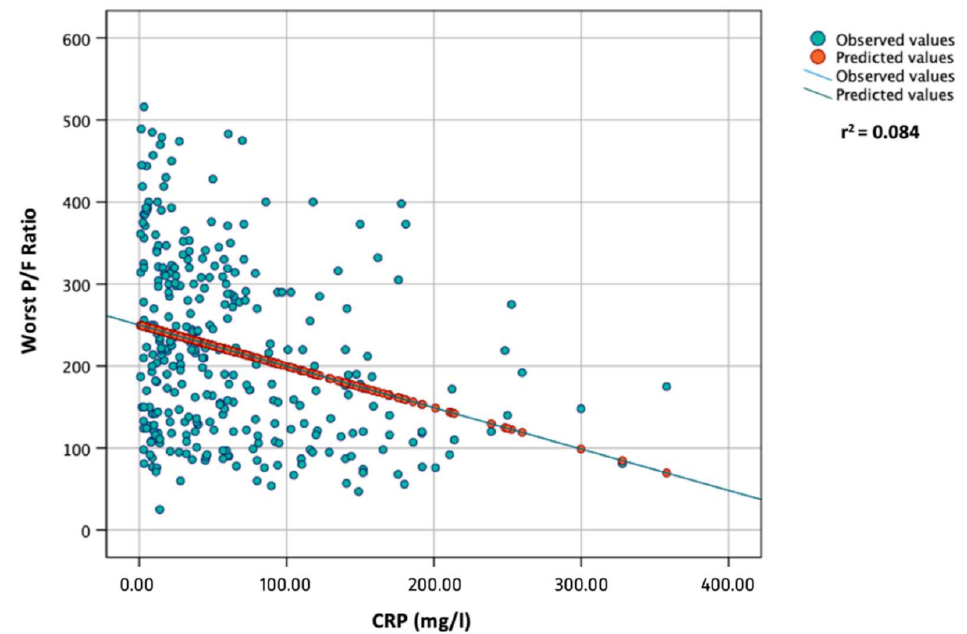
Figure 1. Linear regression analysis between worst P/F ratio during hospitalization (dependent) and CRP levels at admission.